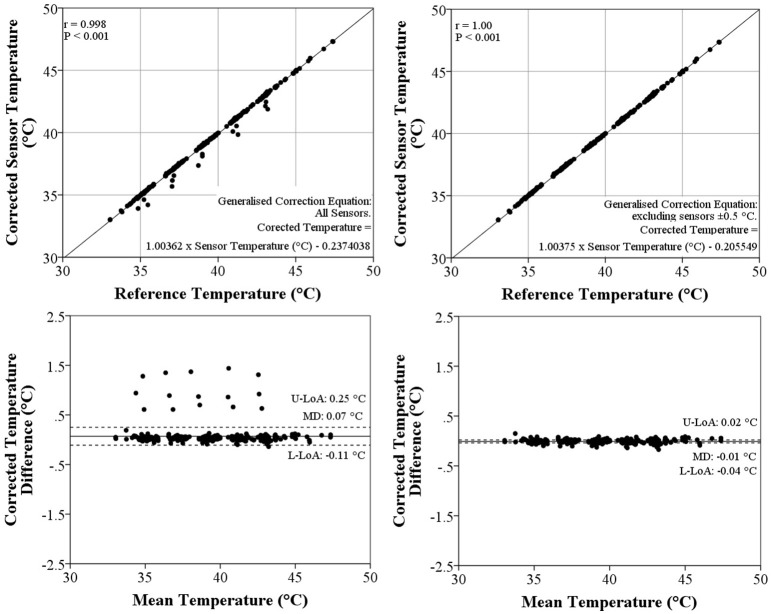
Linear Regressions (Top) and Bland-Altman Plots (Bottom) comparing the Corrected Sensor Temperature with the Reference Temperature. Graphs on the left report the generalized linear equation including all sensors, while graphs on the right show the generalized equation excluding sensors outside ±0.5°C of the reference thermometer. Solid and dashed lines represent the mean difference (MD) and limits agreement (LoA; upper–U, and lower–L), respectively.